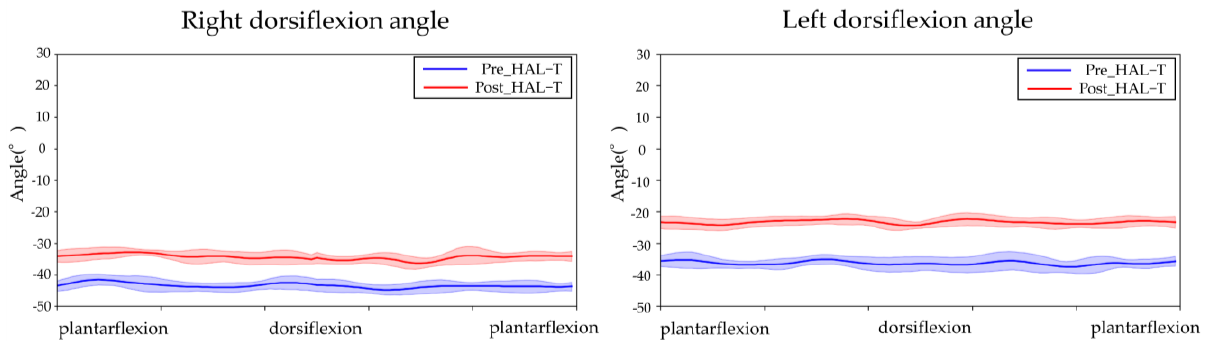
Figure 3. Ankle joint angle during ankle joint plantar dorsiflexion movement in end-sitting position. The blue line shows angle before HAL-T and the red line shows after HAL-T. The 10 ankle plantar dorsiflexion movements were averaged, and the results are shown as means ± standard deviations.